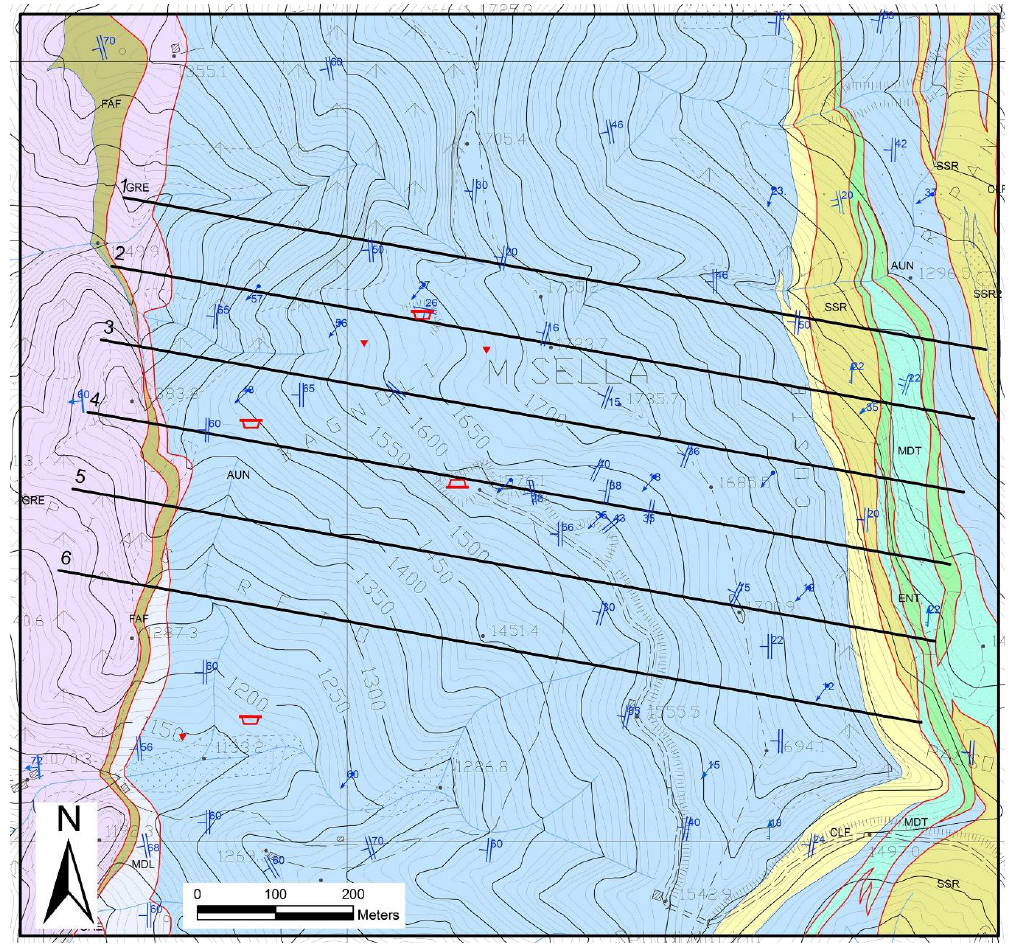
Figure 2. Geological map of the Piastreta underground quarry and surrounding areas. Geological Formation acronyms: FAF: “Filladi Inferiori” (phyllites); GRE: “Grezzoni” (dolomites); MDL: dolomitic marble; AUN: Marble; CLF: Cherty metalimestones; MDT: Metaradiolarites; ENT: Entrochi cherty metalimestones; SSR: Sericitic schists; SSR2: “Cipollini Marbles” (calcschists). Traces of the six geological cross-sections utilized to build the 3D model of Figure 4 are